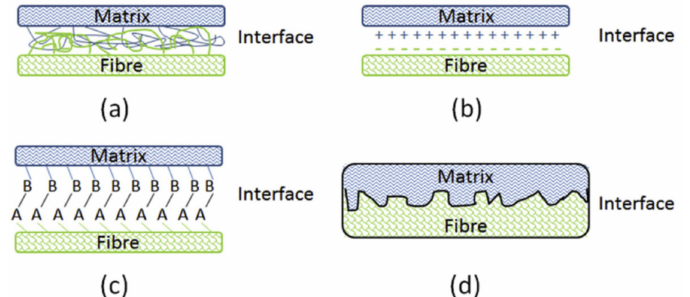
Figure 3. Schematic figure of fibers/matrix interfacial bonding mechanisms with the methods of ( a ) interdiffusion, ( b ) electrostatic adhesion, ( c ) chemical bonding, and ( d ) mechanical interlocking. Reproduced with permission from [27]. Copyright 2016